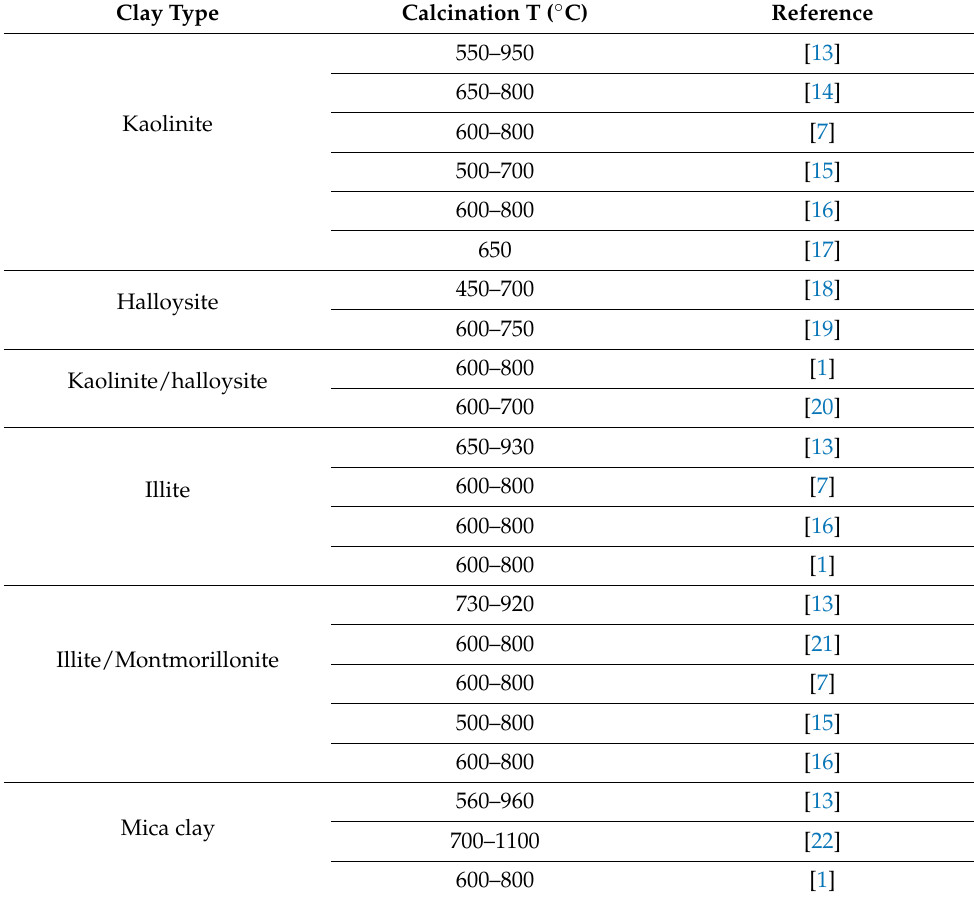
Table 1. Overview of the calcination temperatures for different clay types reported in the